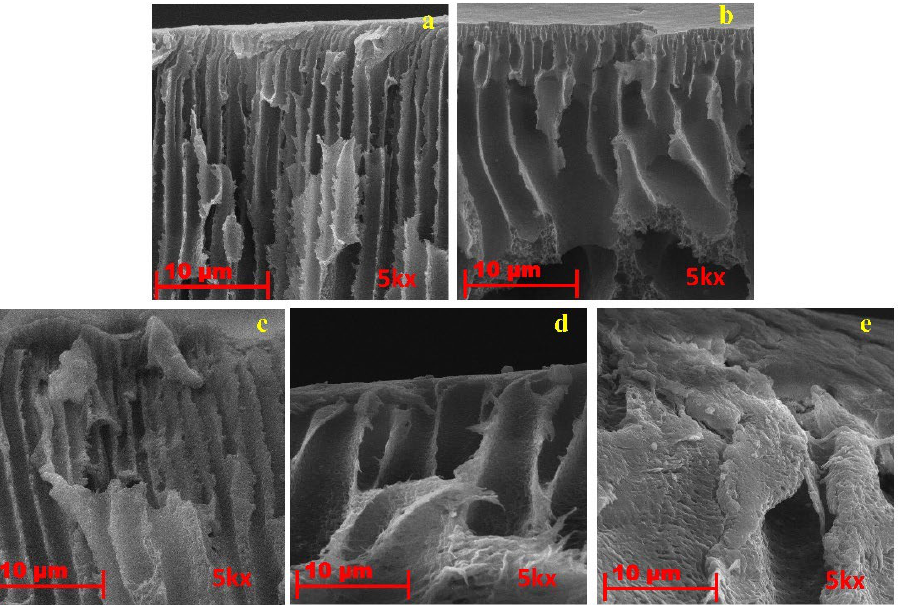
Figure 10. Cross-section SEM images of ( a ) MP0 ( b ) MC1 ( c ) MC4 ( d ) MC7 ( e ) MC10. Sample codes are summarized in Table 1.